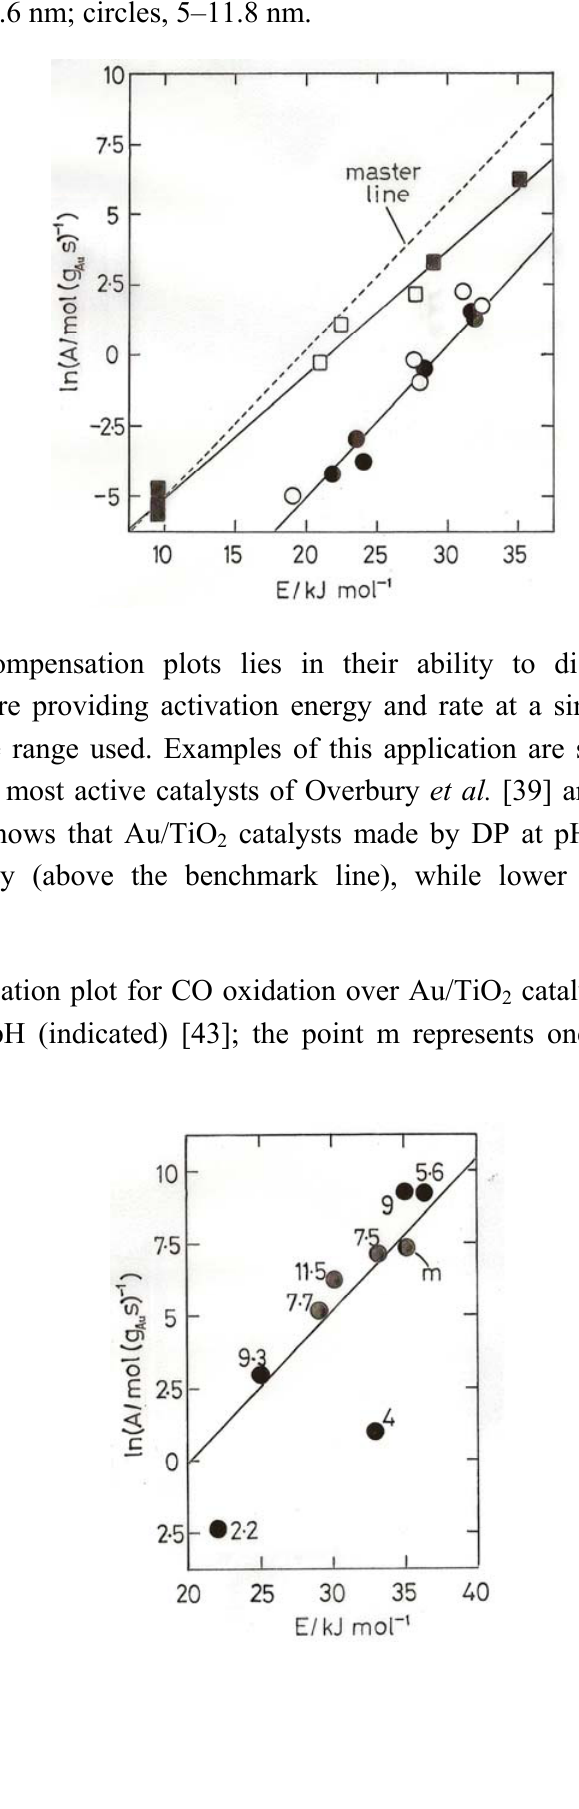
(open points) and 7.2% 2 s) − 1 ) [39]. Square points, Au